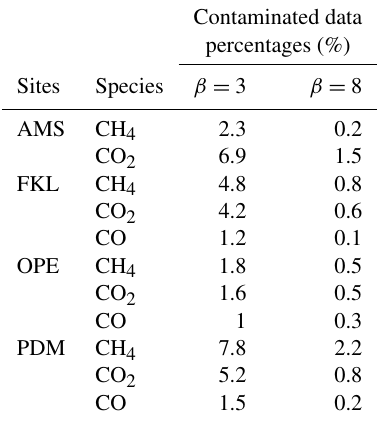
Table 3. Sensitivity of REBS spike detection method for two sets of β ( β = 3 and β = 8) for the four stations and all species for the year